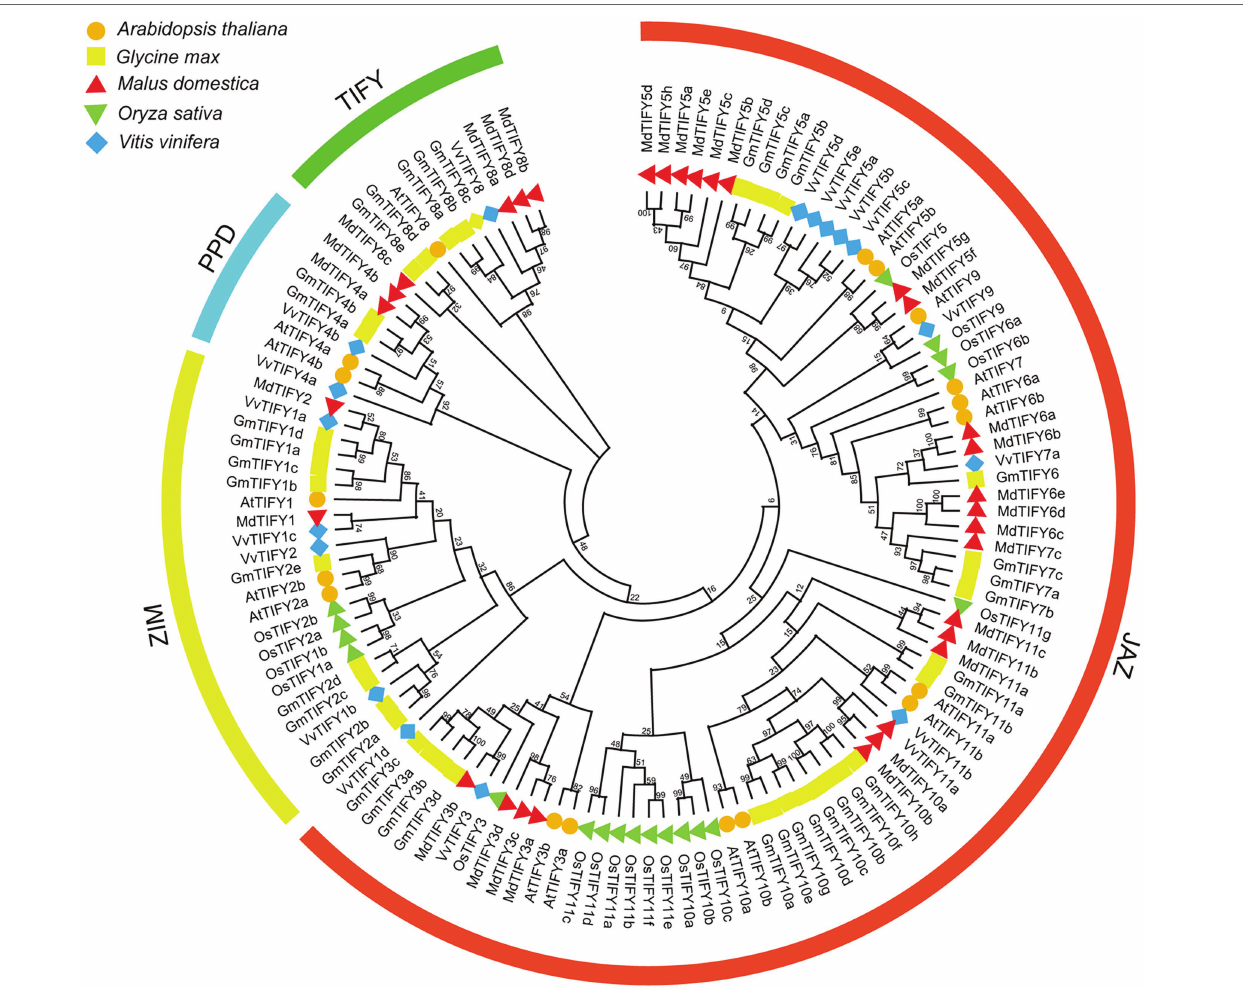
FIGURE 1 | The phylogenetic tree of TIFY proteins from Arabidopsis , rice, grape, apple, and soybean. Multiple sequence alignment was performed by MEGA-X and the phylogenetic tree was constructed using the ML method. The TIFY, JAZ, PPD, and ZIM subfamilies are represented by different